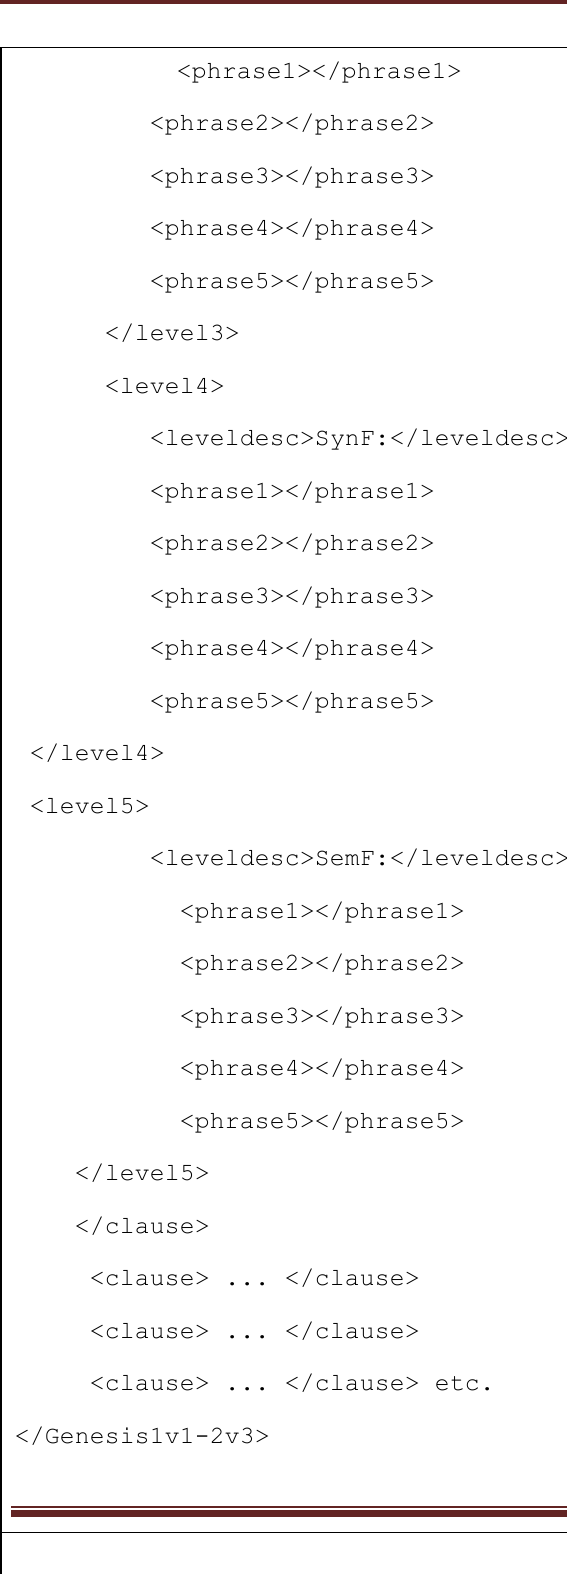
Figure 4. The basic structure of the XML database of Genesis